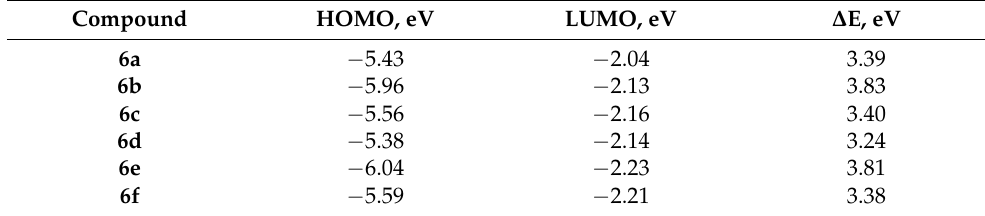
Table 5. HOMO/LUMO based on the functionality B3LYP/6-311G* in the THF phase. Compound HOMO,